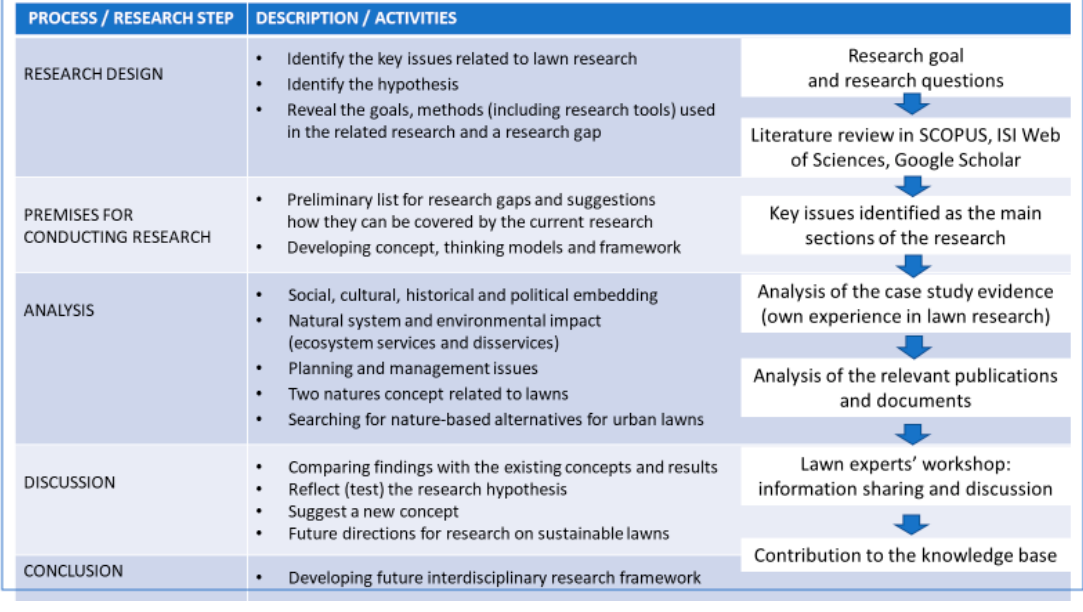
Figure 1. Conceptual framework of this paper.